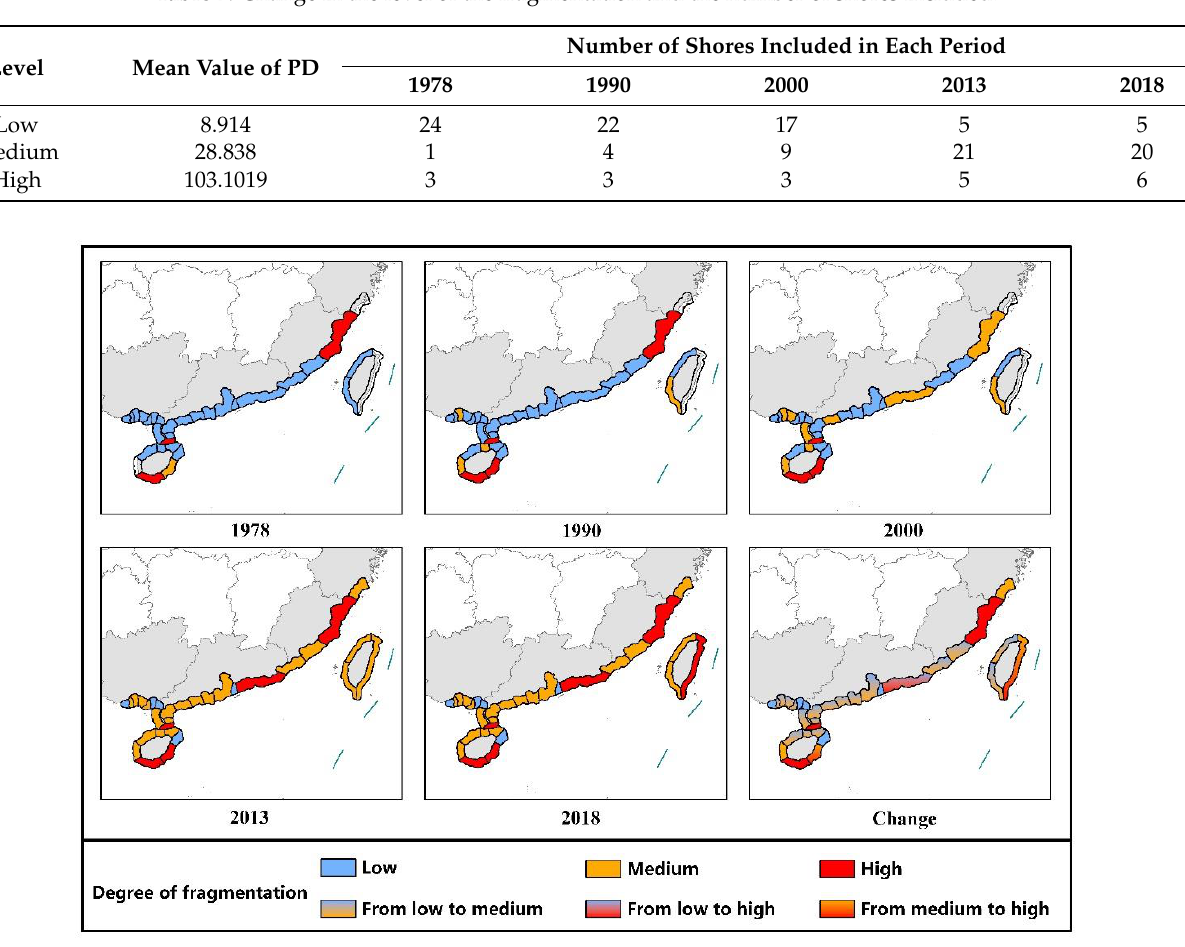
Table 7. Change in the level of the fragmentation and the number of shores included.